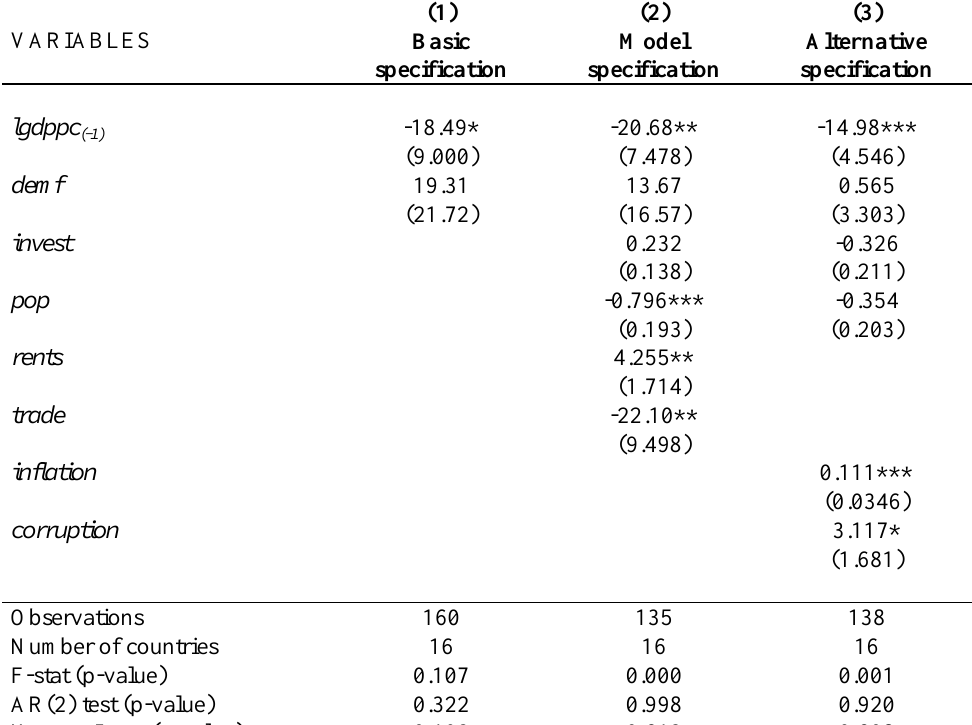
Table A.4: Robustness checks: dropping FDI and govsp from growth